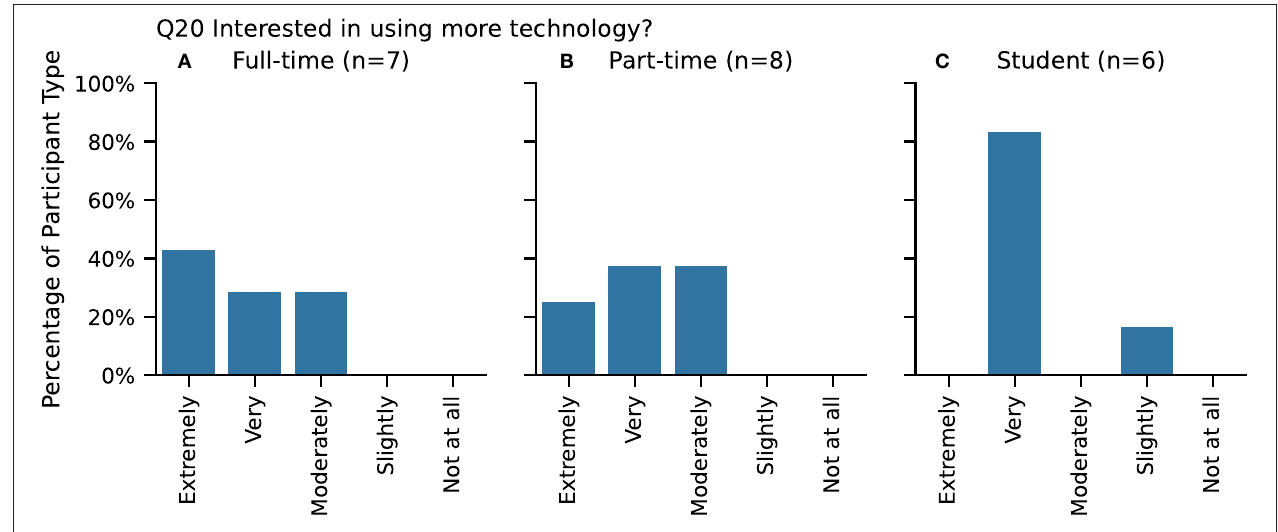
FIGURE 6 | Interest in using more technology for (A) Full-time, (B) Part-time, and (C) Student participants. Participants selected only one